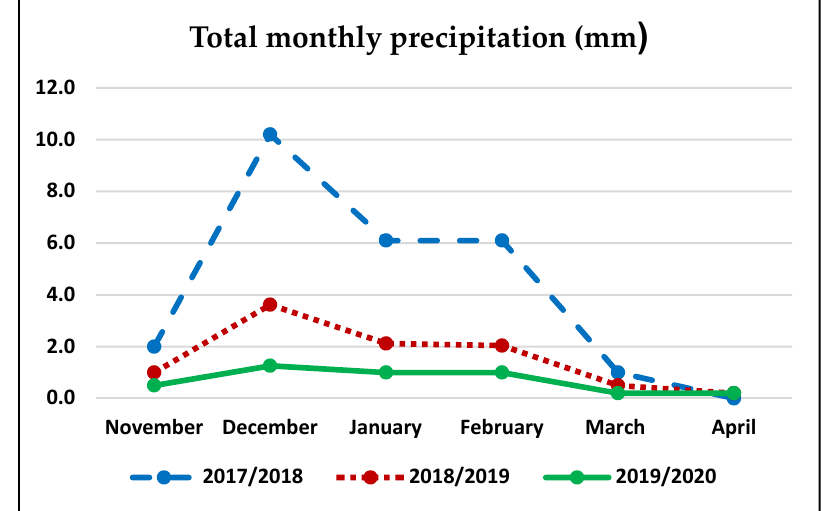
Figure 2. Total monthly precipitation (mm) for the three experimental seasons.